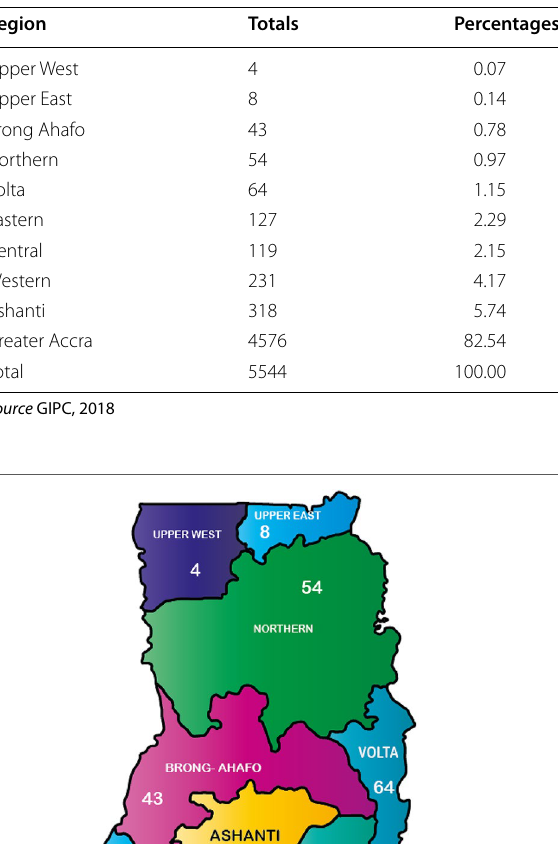
Table 1 Regional distribution of FDI Projects